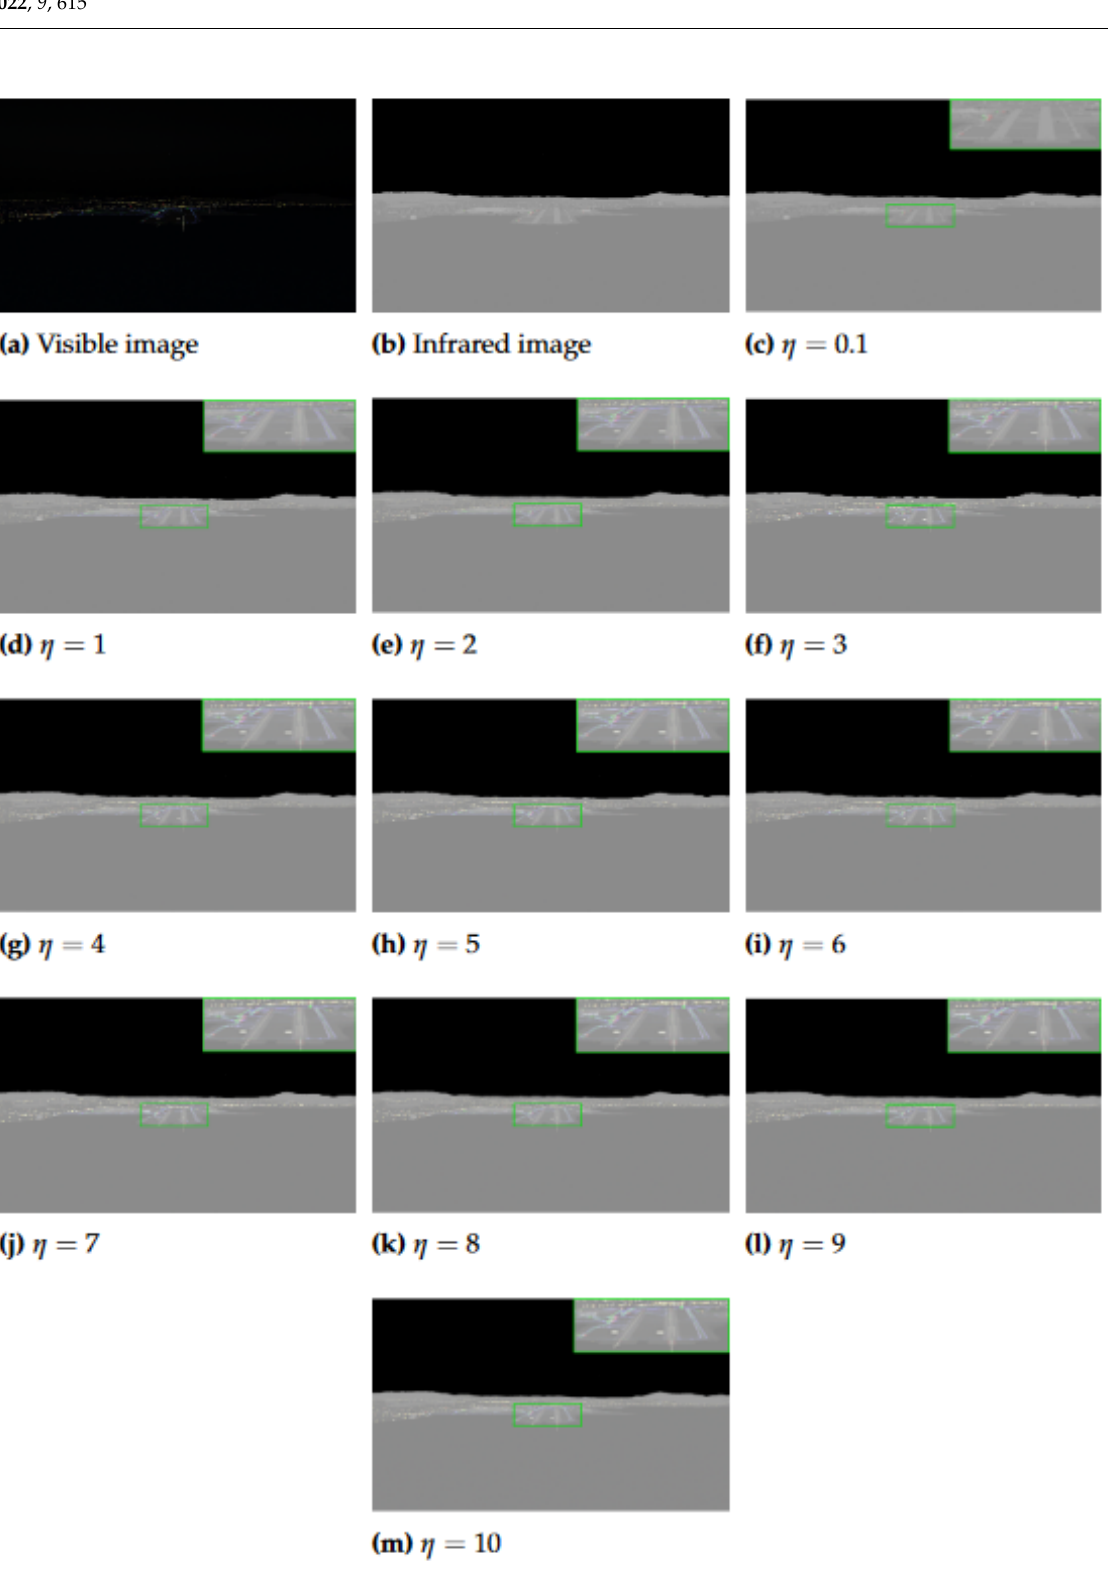
Figure 13. Fused results of Data 3 as η